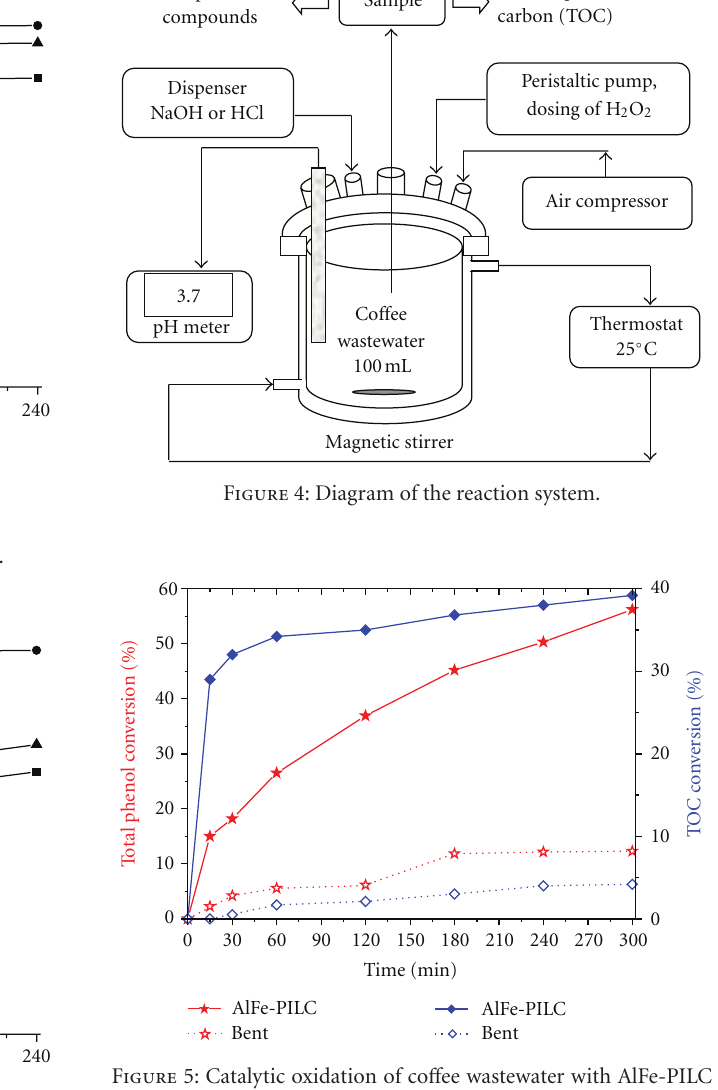
Figure 5: Catalytic oxidation of co ff ee wastewater with AlFe-PILC (continuous line) and Bent (dotted line). Total phenols conversion (star) and TOC conversion